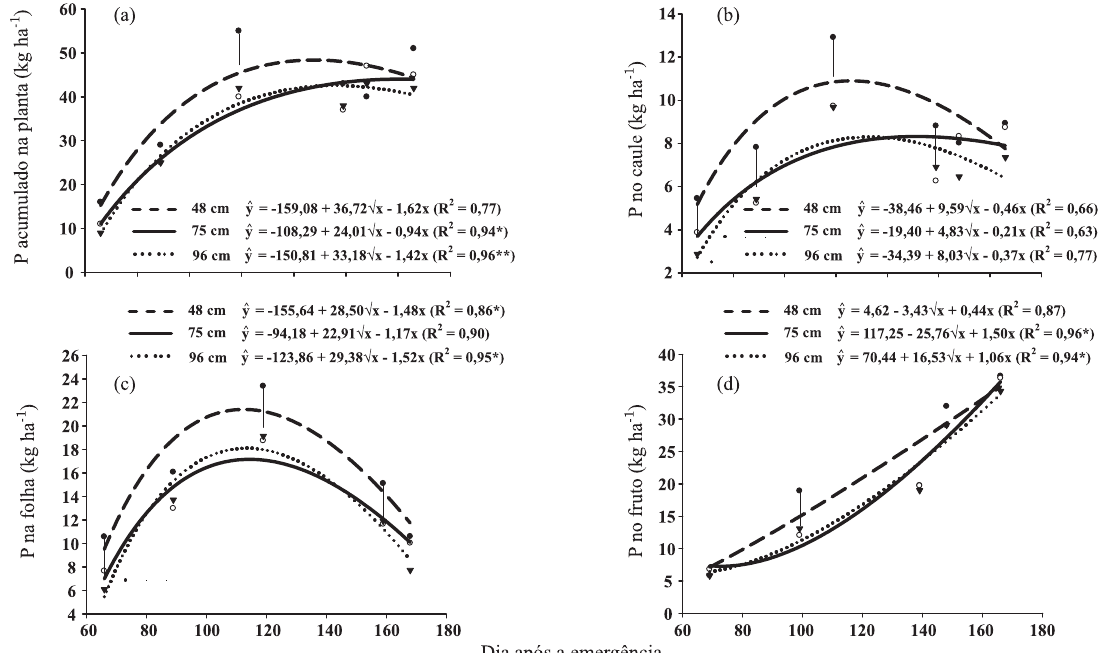
figura 3. fósforo acumulado na planta (a), no caule (b), nas folhas (c) e nos frutos (d) do algodoeiro cul- tivado nos espaçamentos de 48 ( ), 75 ( ) e 96 cm ( ). A barra vertical representa a diferença mínima significativa (dms p <